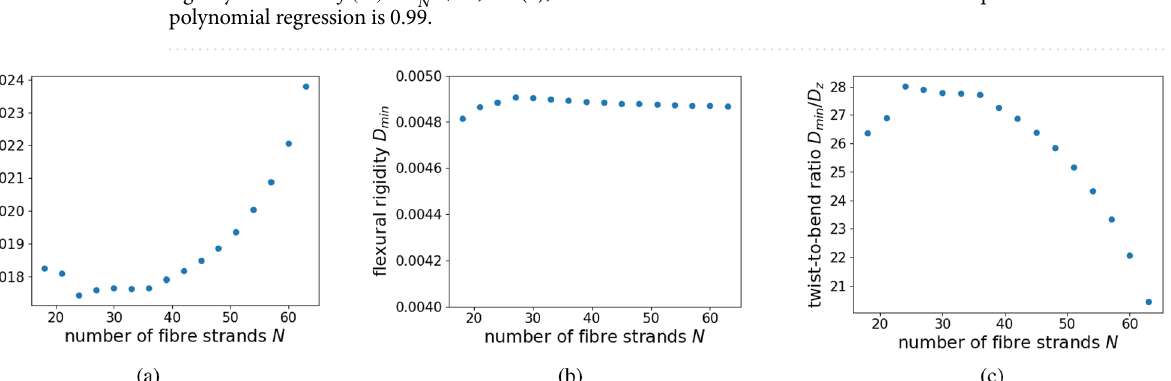
Figure 5. Reinforcement by hypothetically occurring collenchyma fibre strands. Trend of ( a ) torsional rigidity, ( b ) flexural rigidity and ( c ) twist-to-bend ratio. The ratio µ between the elastic moduli of the parenchyma and collenchyma is µ = 0.008 . The collenchyma and parenchyma are the mechanically decisive